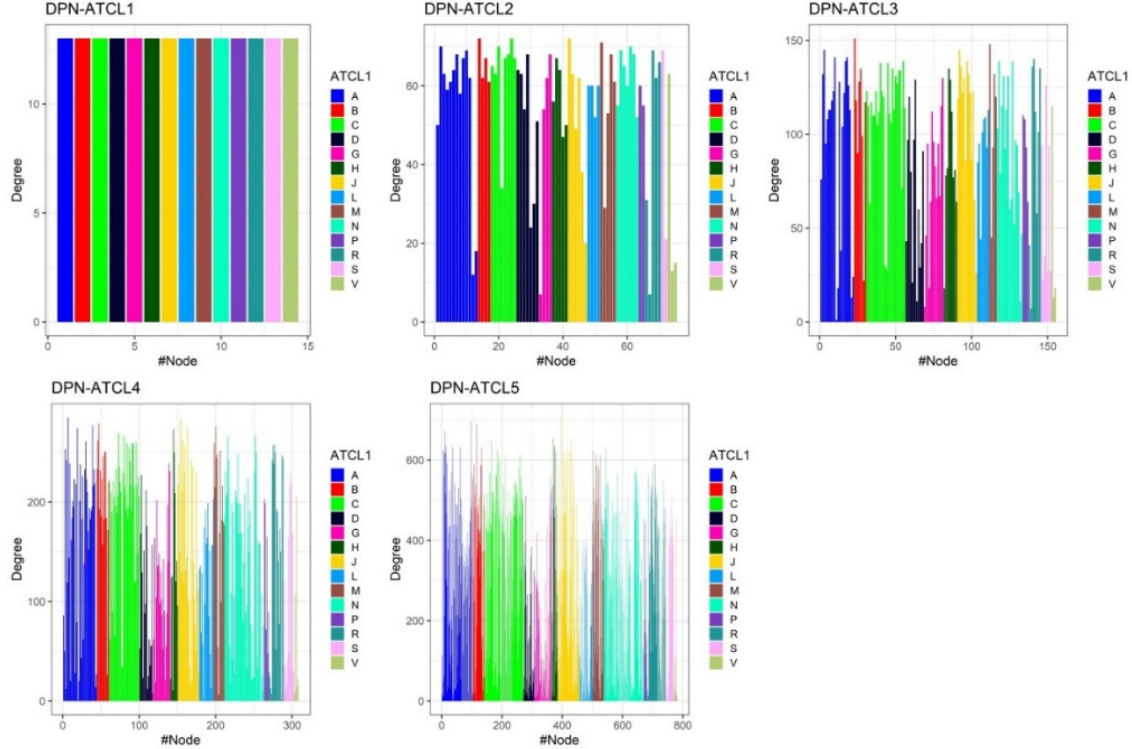
Figure A3. Individual node degree. Data on drug prescription have been represented in the form of DPNs (ATCL1–ATCL5). Individual node degrees were computed and are displayed as bar charts. Nodes are coloured according to the 14 groups found at the first level of the ATC classification system.